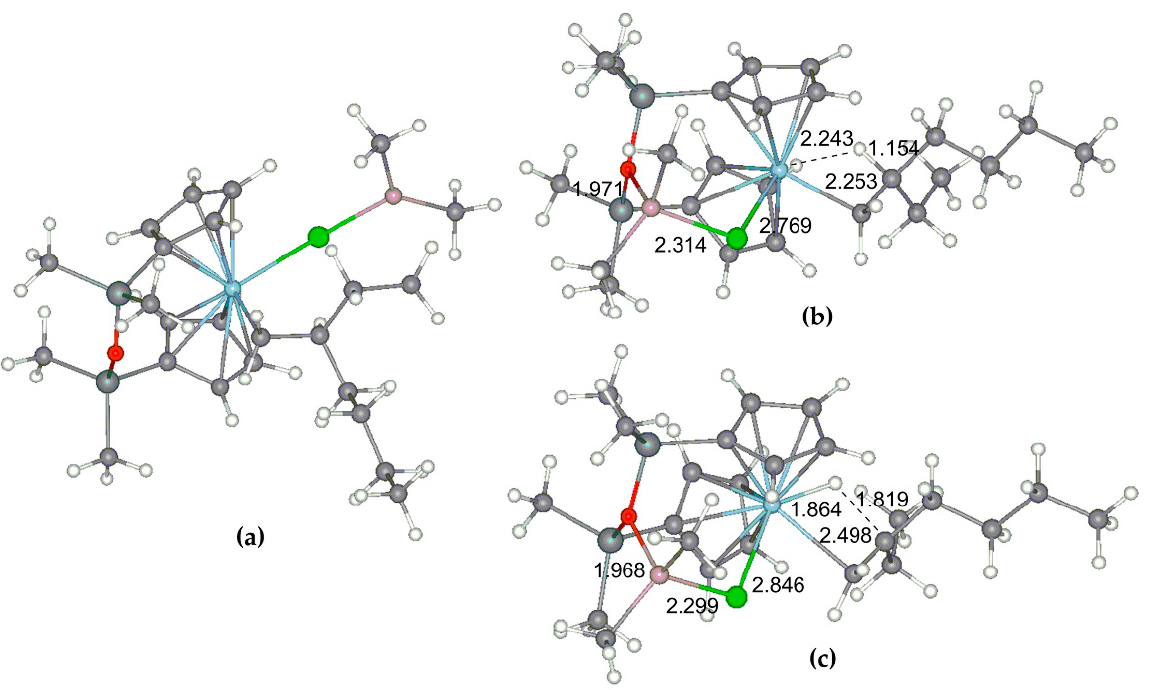
Figure 21. Optimized geometries of O[SiMe 2 ( η 5 -C 5 H 4 )] 2 Zr–derived stationary points I-5pp-Cl ( a ), I-5pp-c-Cl ( b ), and transition state TS-56pp-c-Cl ( c ). Reprinted with permission from [42]. Copyright (2020) MDPI.